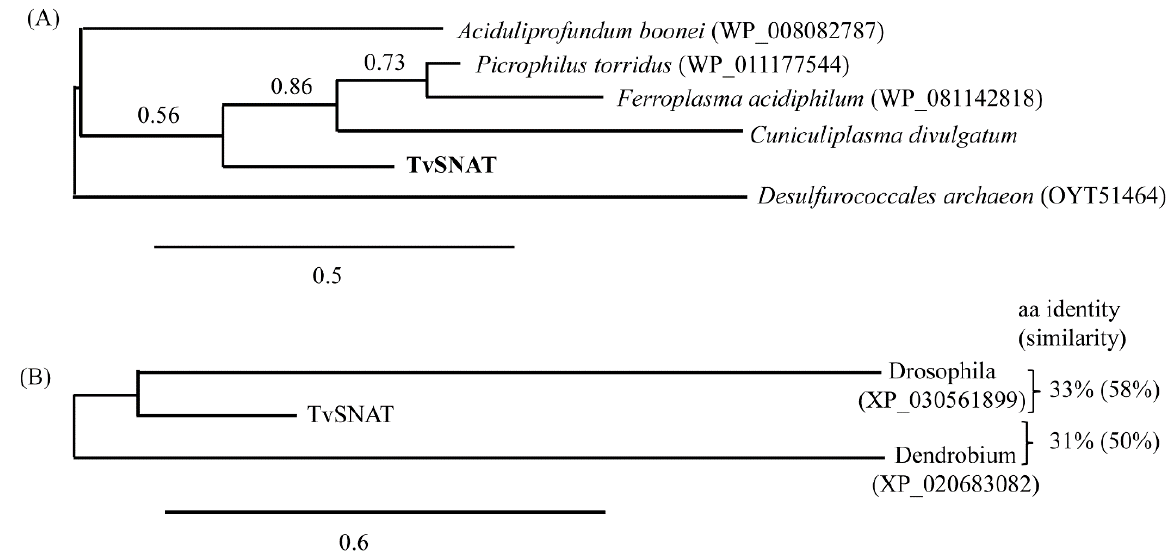
Figure 5. Phylogenetic analysis of TvSNAT constructed using the neighbor-joining method for ( A ) Archaea and ( B ) Animalia and Plantae. Scale bars in ( A , B ) represent 0.3 and 0.6 substitutions per site, respectively. Numbers in parentheses are GenBank accession numbers of corresponding genes. Alignments and the phylogenetic analyses were performed using the BLAST-Explorer tool (www.phylogeny.fr, accessed on 6 November